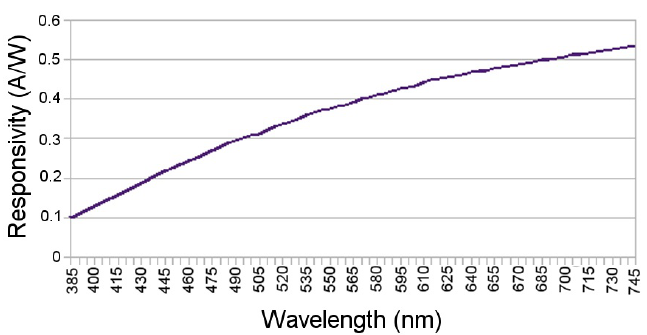
Figure 12. Silicon Responsivity data extracted from [18].